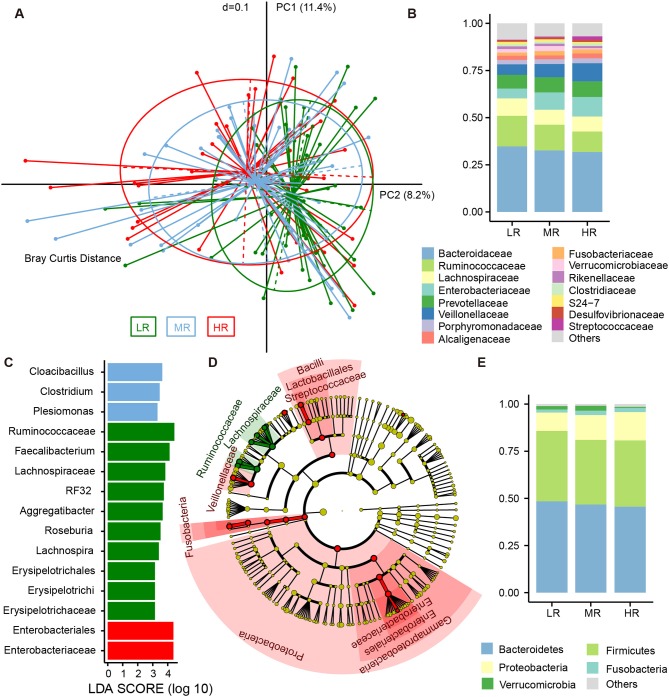
Differences in the composition of gut microbial communities between the LR (n = 51, green), MR (n = 54, blue), and HR (n = 36, red) groups. (A) Beta diversity comparison among the three groups. Principal coordinates analysis (PCoA) based on Bray–Curtis distance was used to illustrate the variations between the three groups. Average relative abundance of dominant microbes among the LR, MR, and HR groups at the family level (B) and phylum level (E), with each color representing a taxon. (C) Significantly discriminative taxa among the LR, MR, and HR groups were determined using linear discriminant analysis effect size (LEfSe) analysis. (D) Cladograms based on LEfSe results of the LR and HR groups. LR, low-risk group; MR, medium-risk group; HR, high-risk group.